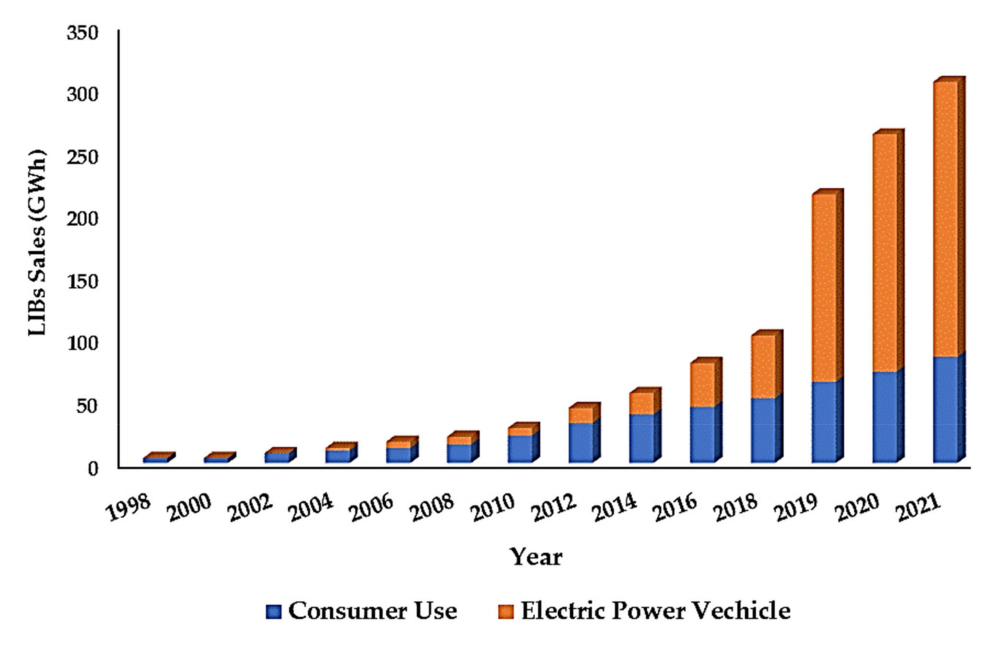
Figure 1. The increasing demand for